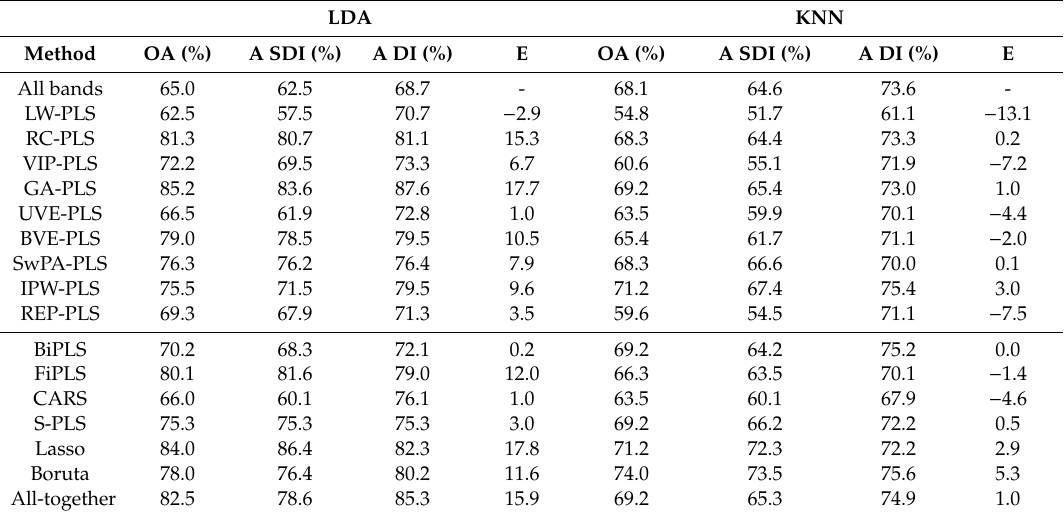
Table 5. Overall accuracy (OA), Accuracy of Sub-Surface drip irrigation (A SDI), Accuracy of Surface drip irrigation (A DI) and E ffi ciency (E) results of Linear Discriminant Analysis (LDA) and K-Nearest Neighbors (KNN) using di ff erent selection